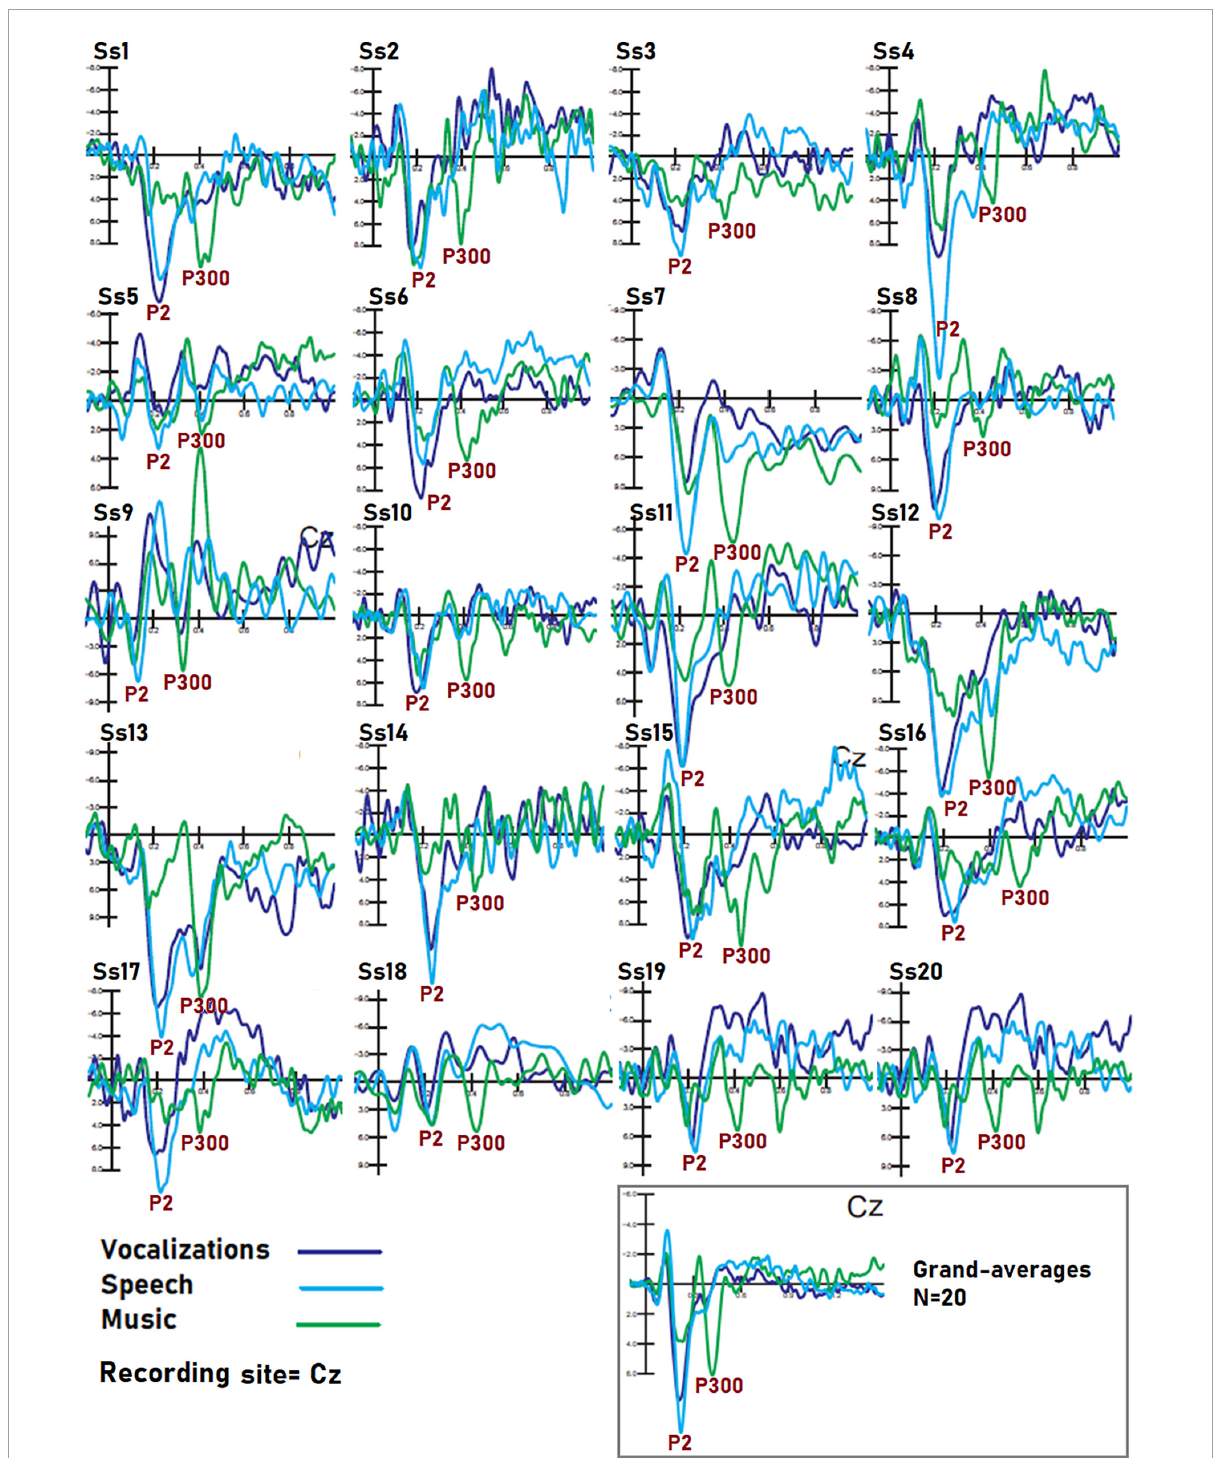
FIGURE9 Individual data of subjects. Dataset recorded from 20 participants in response to auditory stimuli of the three classes. The example shows that despite the obvious inter-individual differences in electrical potentials, markers of speech, music, and vocalization processing were visible in each individual, so it is reasonable to assume that BCI performance on each person’s dataset would be still good. Further research is needed to reach a definitive conclusion on this